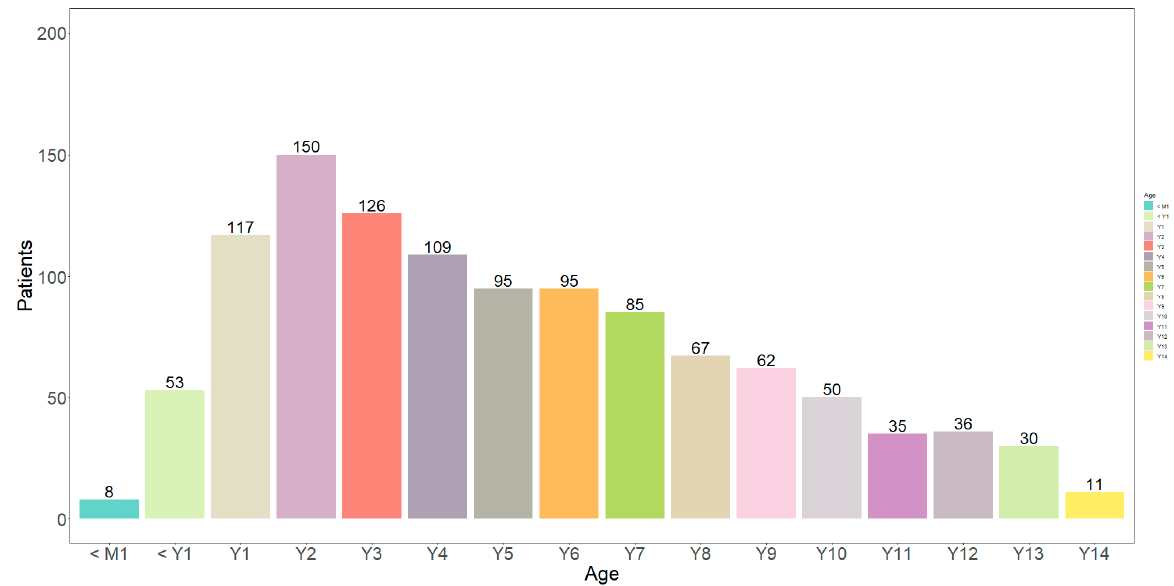
Figure 3. Age distribution of pediatric orthopedics patients from 2006 to 2021.